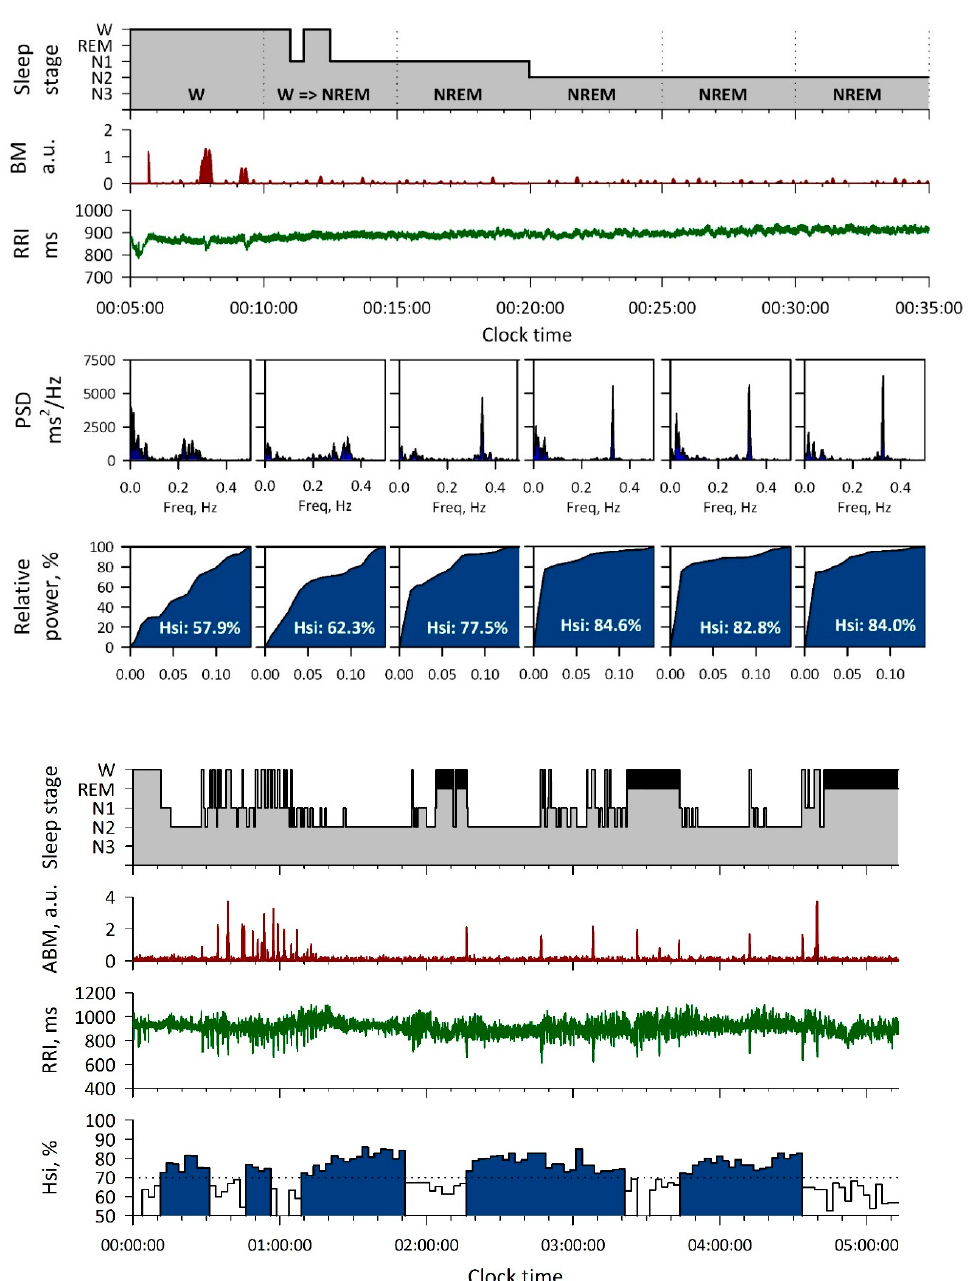
Figure 2. Hsi of a healthy male subject at the onset of sleep. From the top, hypnogram, actigraphic body movement (BM), R-R interval (RRI) power spectrum, and Hsi. As the sleep stage changes from waking (W) to NREM (N1, N2, and N3), large BM disappears, a sharp peak appears in high frequency band (0.15–0.4 Hz) in RRI power spectrum, and Hsi (area under the curve) increases above 70%. In the bottom panels, ω is the frequency rage to integrate the spectral power around the high frequency peak. PSD = power spectral density. From 141 subjects, a total of 11,636 segments of data were obtained, including 2261 (17.1%) awake, 6891 (52.2%) NREM, 2484 (18.8%) REM, and 1578 (11.9%) transitional segments. The average